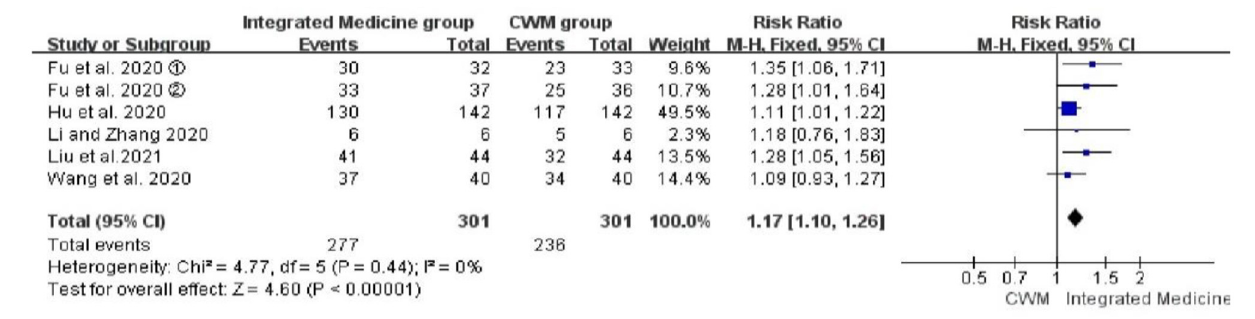
FIGURE 3 | Forest plot of the overall effective